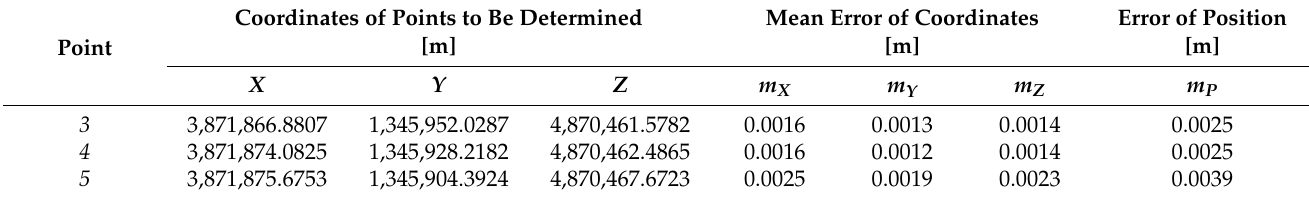
Table 7. Adjusted coordinates and mean errors (integrated